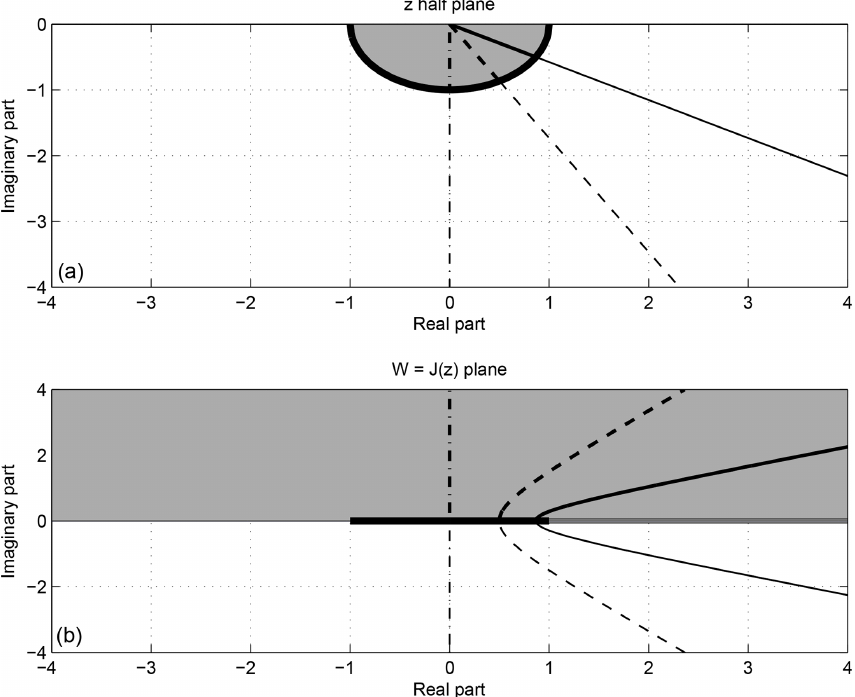
Figure 11. In (a) the half complex plane (cid:61) (z) ≤ 0 with z = ξz 1 is shown. The domain is restricted to complex numbers with a negative imaginary part since k I = a (cid:61) (z)/(ξR 0 ) must be negative. The half circle | z | = 1 and a few straight lines have been drawn. In (b) , the Joukowsky transform of the previous half plane W = J(z) is shown. The segment [− 1 , 1 ] is the image of the half circle. The upper (lower) half plane corresponds to the image of its interior (exterior). The image of the straight lines is correspondingly